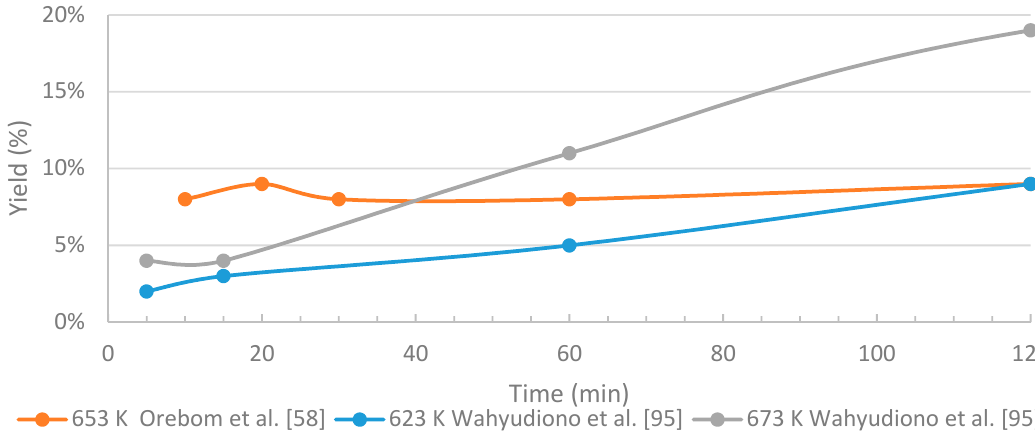
Figure 11. The influence of residence time on char yield. All the experiments were performed in batch reactors. The curves are guides to the eye.